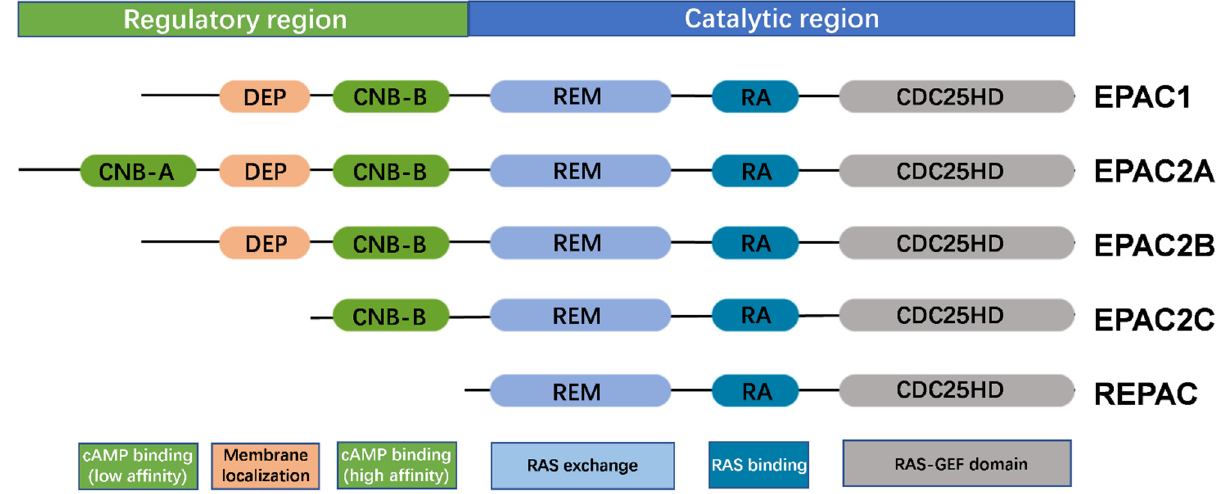
Figure 1. Domain architecture of EPAC1 and EPAC2 isoforms. EPAC1 and EPAC2 isoforms consist of N-terminal cAMP-binding domains and C-terminal guanine nucleotide exchange factor (GEF) domain. The REPAC isoform lacks the cAMP binding (CNB) domain. The N-terminal regulatory region includes a disheveled Egl-10 pleckstrin homology domain and one or two cyclic nucleotide binding domains. The C-terminal catalytic region contains a RAS exchange motif, a RAS-association domain, and a CDC25 homology domain.